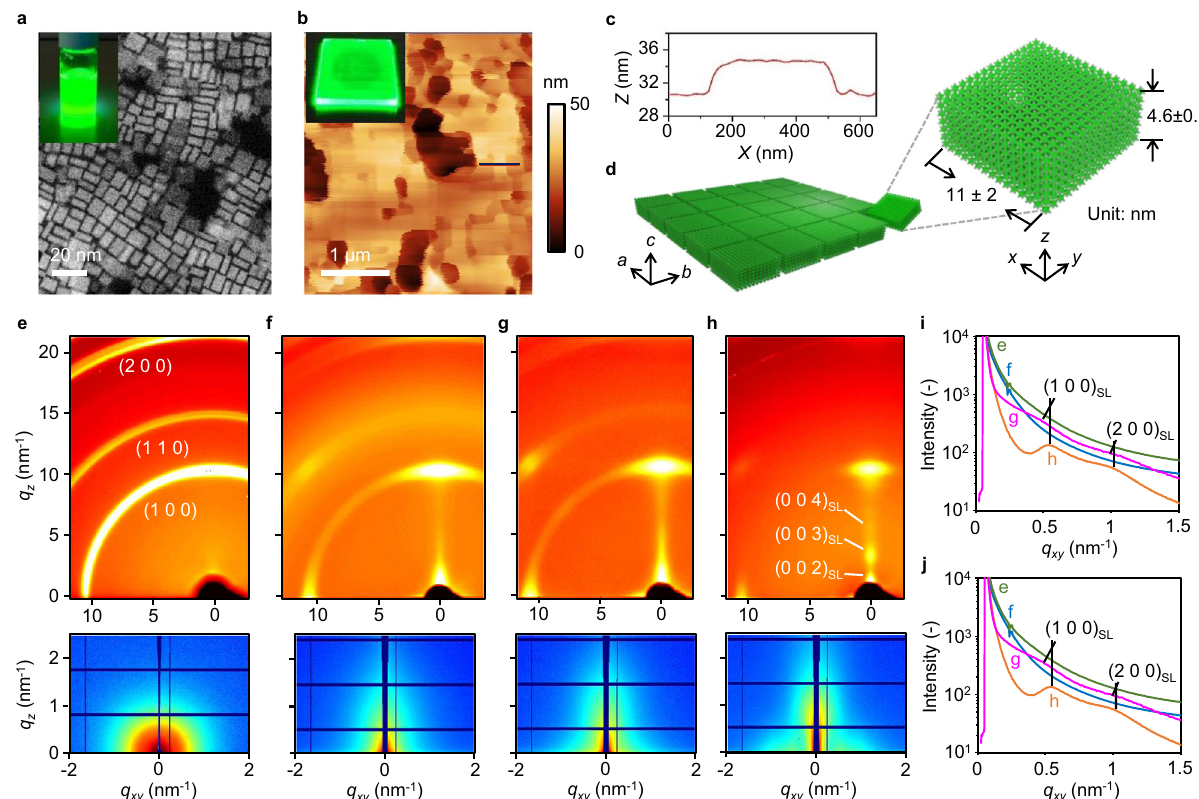
Fig. 2 Self-assembly engineering for controlling the formation of ANC superlattices. a TEM image and photograph of colloidal solution exposed to UV light for the synthesized ANCs. b Representative AFM height image and photograph exposed to UV light for the fabricated ANC superlattice fi lm in ( g ). c Cross-sectional height pro fi le corresponding to the black line in ( b ), revealing lateral assembly of ANCs in the xy (substrate) plane. d Schematics of ANC ANSL showing the superlattice ab plane coincides with the xy plane and the SL c axis in parallel to the z vector. GIWAXS (top) and GISAXS (bottom) patterns for the drop-casted fi lm ( e ), spin-coated fi lm on poly-TPD ( f ), spin-coated fi lm on low-surface-energy X-F6-TAPC ( g ), and spin-coated fi lm on X- F6-TAPC comprising NPLs synthesized using OLA ligands ( h ). The Miller index ( a b c ) SL refers to a superlattice plane. i q xy cuts for the GISAXS patterns in ( e – h ). j Comparison of orientation distribution function for the emissive fi lms considered here using the normalized scattering intensity of the (100) DS ring with respect to χ , revealing an enhanced horizontal orientation upon ANSL